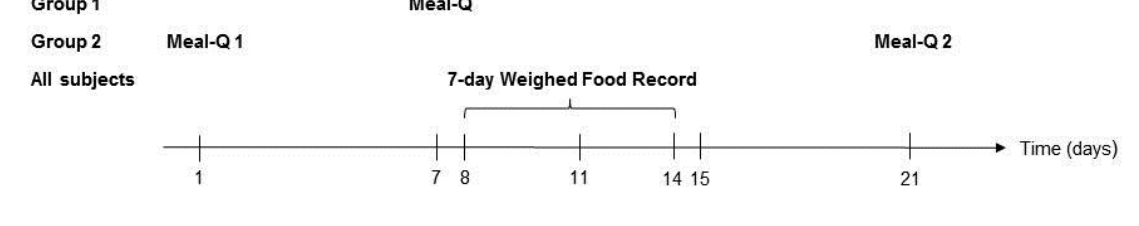
Figure 1. The 3-week study scheme of the VALidation of Methods Assessing diet and physical activity (VALMA) study. Data from the first administered Meal-Q from both groups was compared to the WFR for validity analyses. The same data from Meal-Q was truncated for simulated validity analysis of MiniMeal-Q. Meal-Q was distributed twice in group 2 for reproducibility